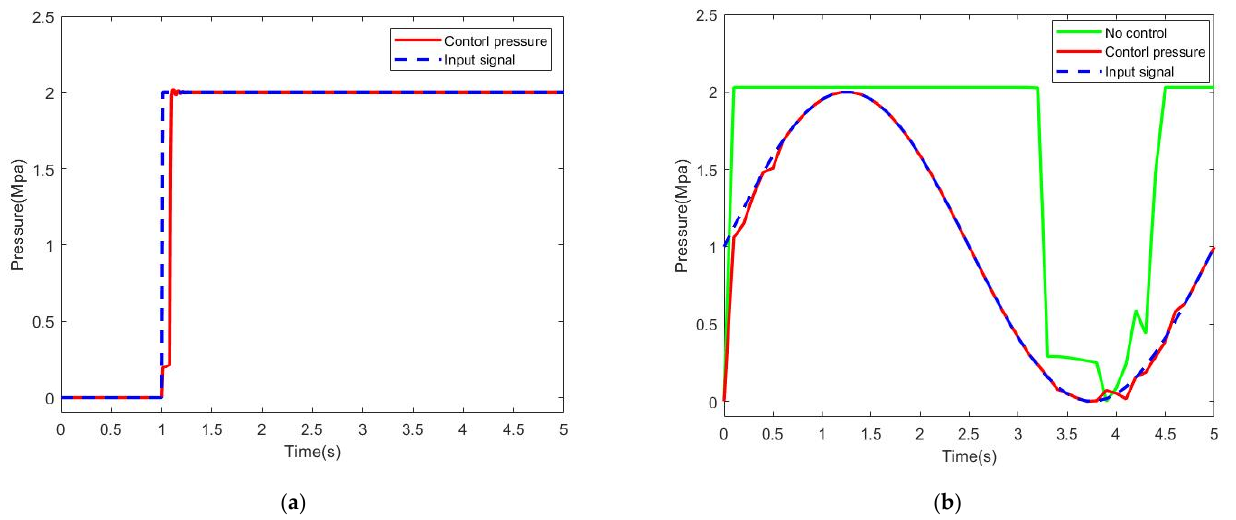
Figure 9. Clutch response curve under different control signals. ( a ) Step signal control; ( b ) Sinusoidal signal